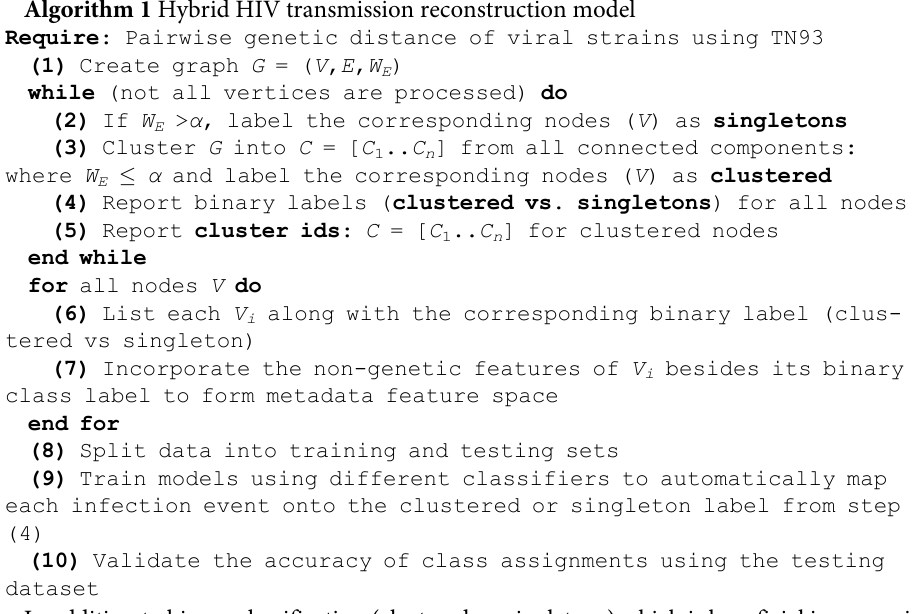
Algorithm 1 Hybrid HIV transmission reconstruction